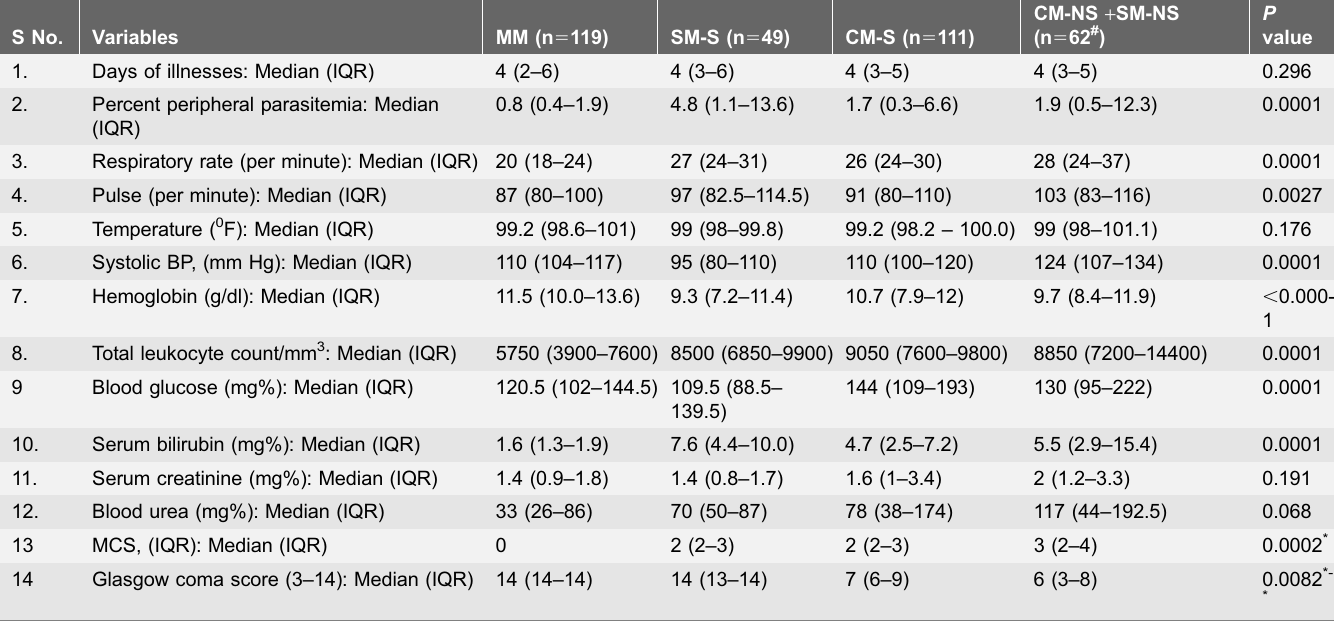
Table 2. Malaria category-wise clinical characteristics of enrolled